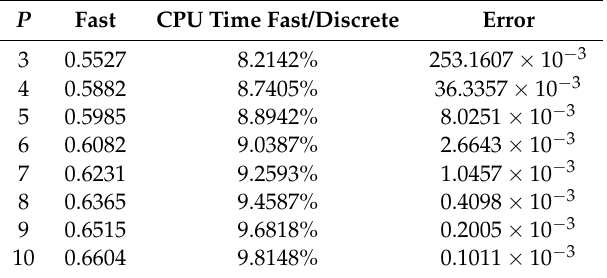
Table 3. Error and CPU time evolution for the filter with dielectric posts (four cavities) as the number of frequency points for the fast sweep ( P ) increases. Discrete sweep used 500 points and took 6.729